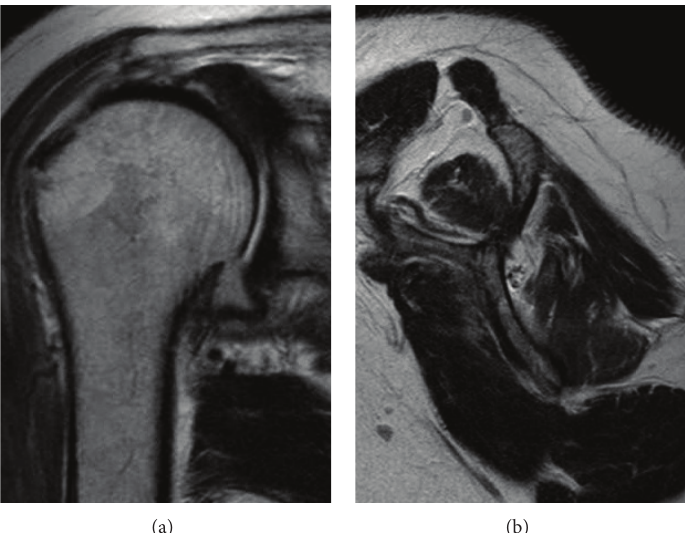
Figure 3: MRI imaging upon initial presentation to our hospital. (a) Coronal view of T2 shows a large tear approximately 3 cm long in the supraspinatus tendon. (b) Oblique sagittal view of T2 shows atrophy and fatty degeneration of the supraspinatus muscle.